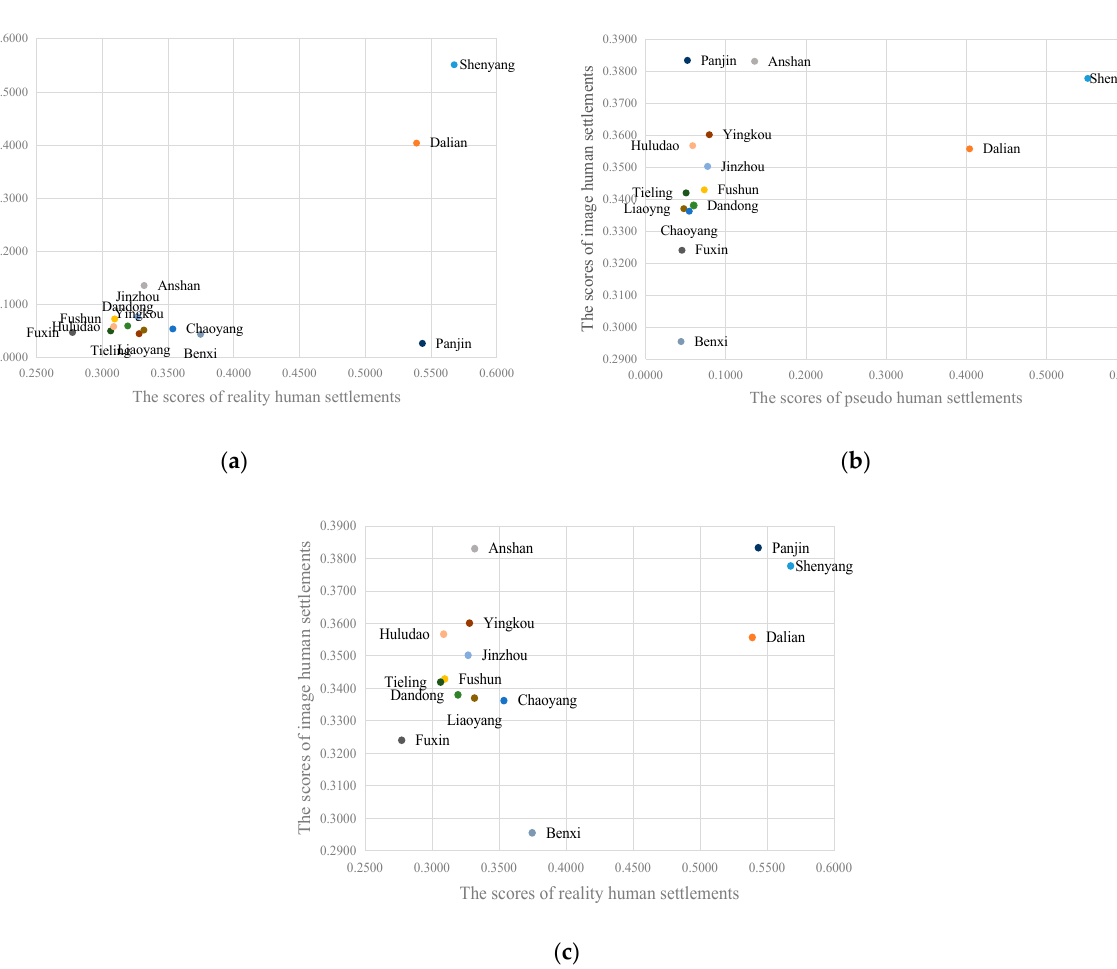
Figure 5. Two-dimensional planar mapping of three-dimensional index structure of reality-pseudo- image state: ( a ) reality-pseudo human settlements; ( b ) pseudo-image human settlements; ( c ) reality- image human settlement.